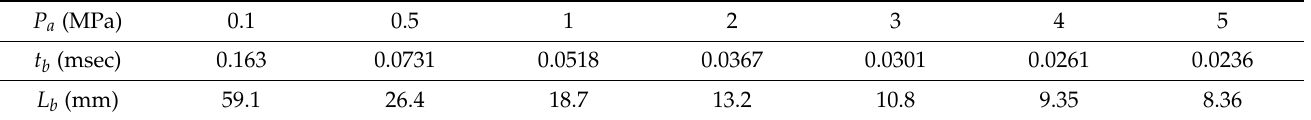
Table 3. Length and time of breakups for tested spray jets.